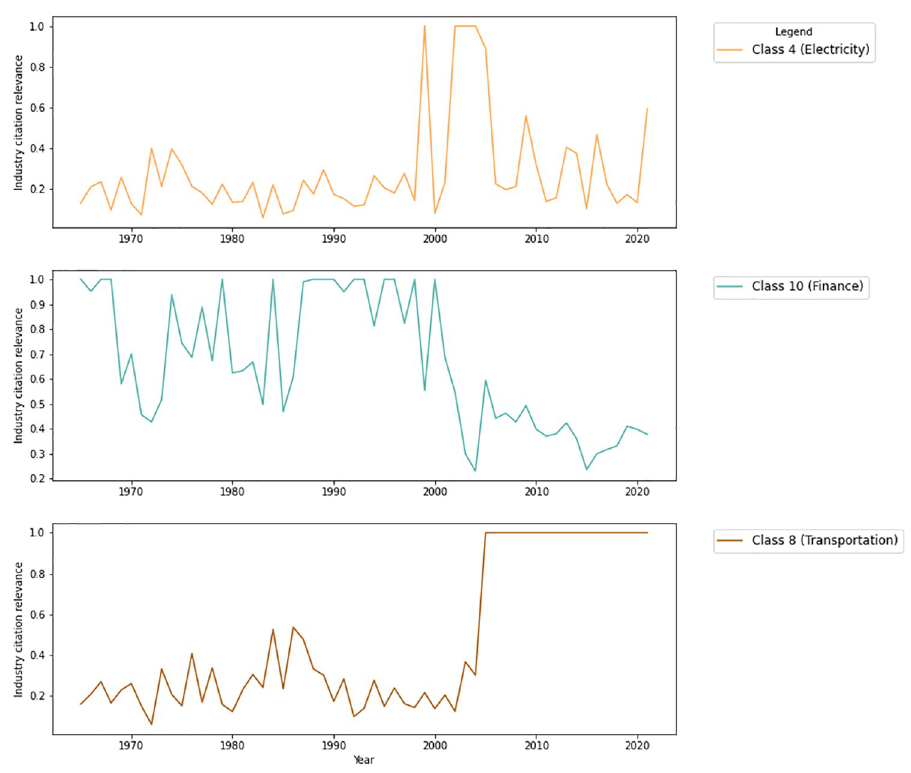
Fig 8. Industry citation relevance for eletricity, finance and transportation economic sectors.